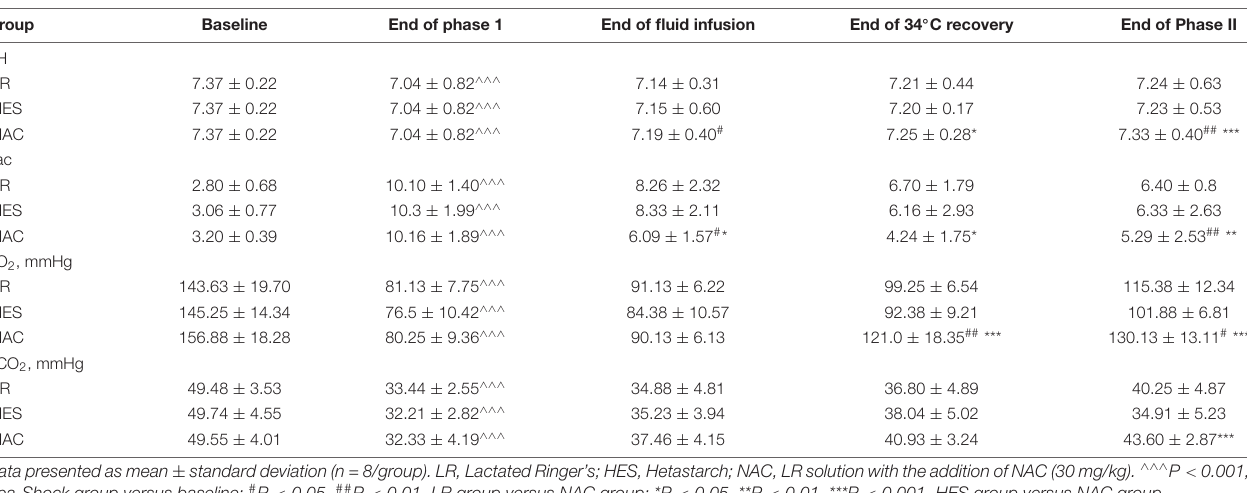
coagulation function parameters using ACL TOP 700 before and after Sea-Shock and at the end of Phase II. Thrombin time (TT), prothrombin time (PT), international normalized ratio of